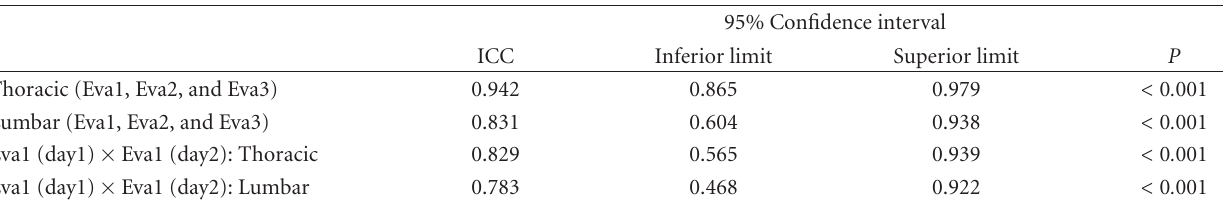
Table 1: Intraclass Correlation Coe ffi cient (ICC) between the evaluations of the thoracic and lumbar curvatures measured with the flexicurve performed by three di ff erent evaluators (Eva1, Eva2, and Eva3) and between the first and second evaluation days performed by the same evaluator (day1,